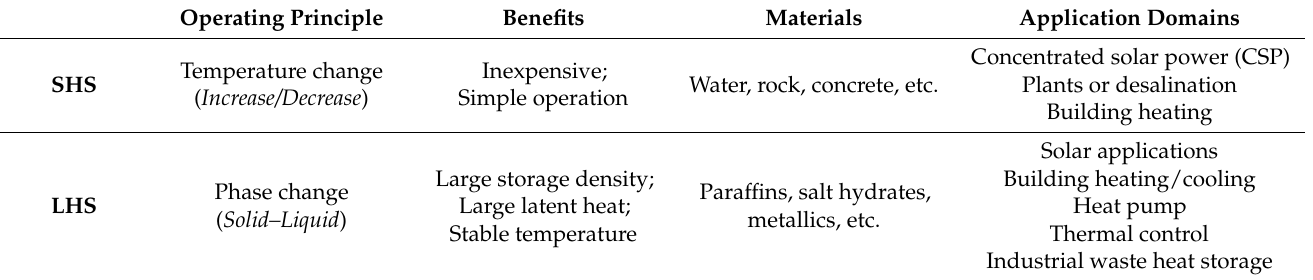
Table 6. Comparison between SHS and LHS techniques [5,60,114], reprinted/adapted with permis- sion from Ref. [114], 2022,